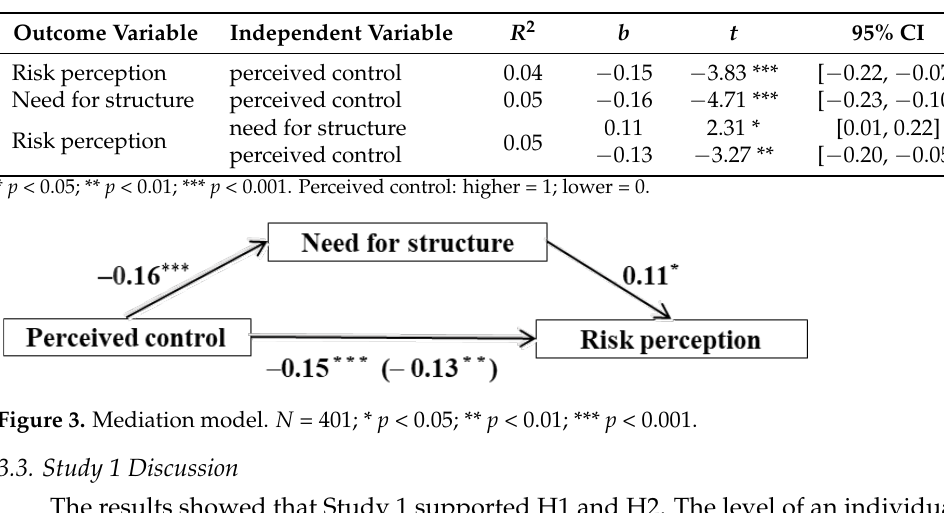
Table 2. Study 1 mediation effects analyses ( N = 401).